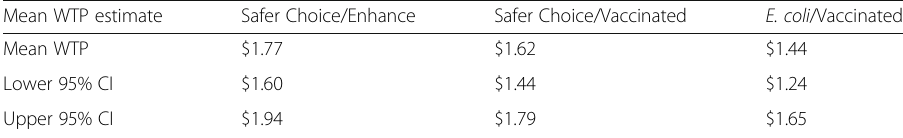
Table 7 Estimates of mean WTP for the food safety labels Mean WTP estimate Safer Choice/Enhance Safer